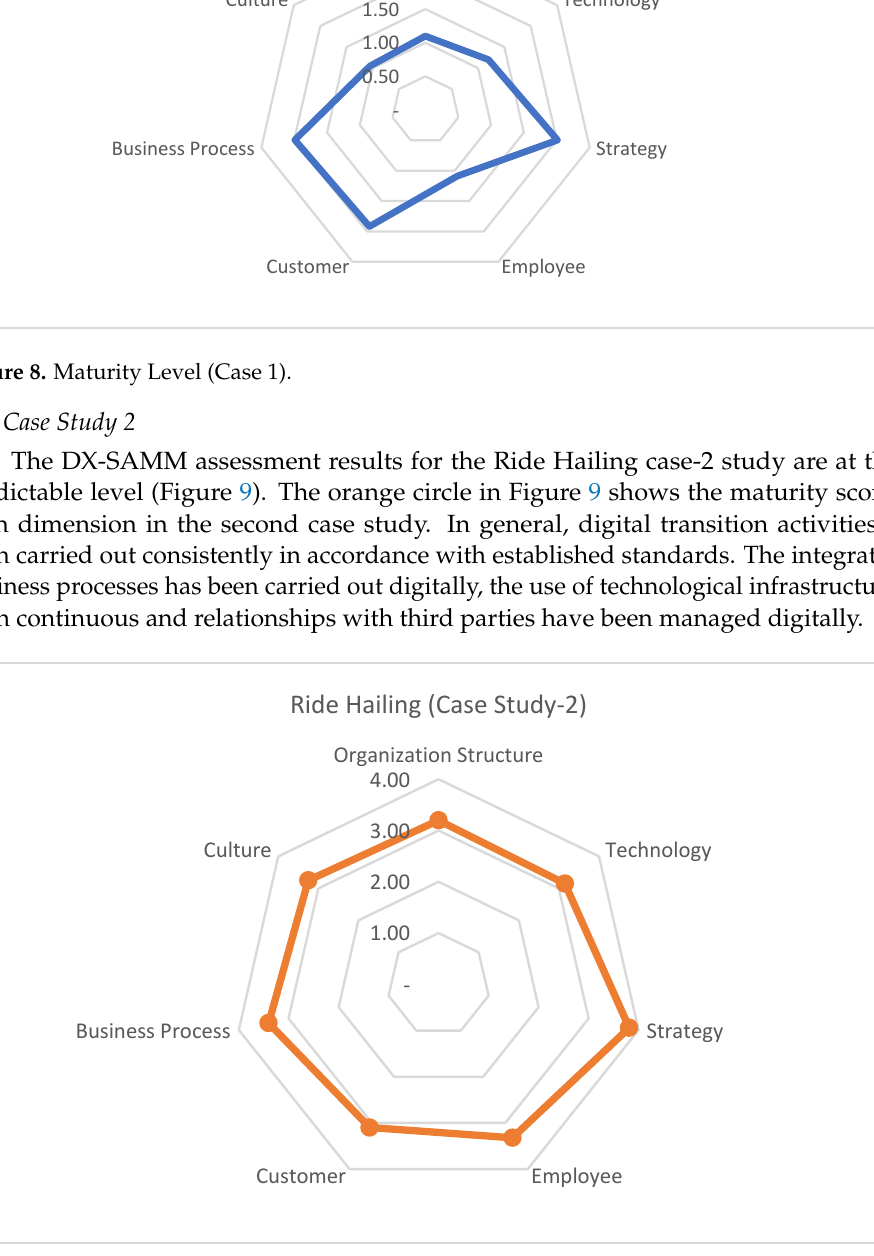
Figure 9. Maturity Level (Case 2).